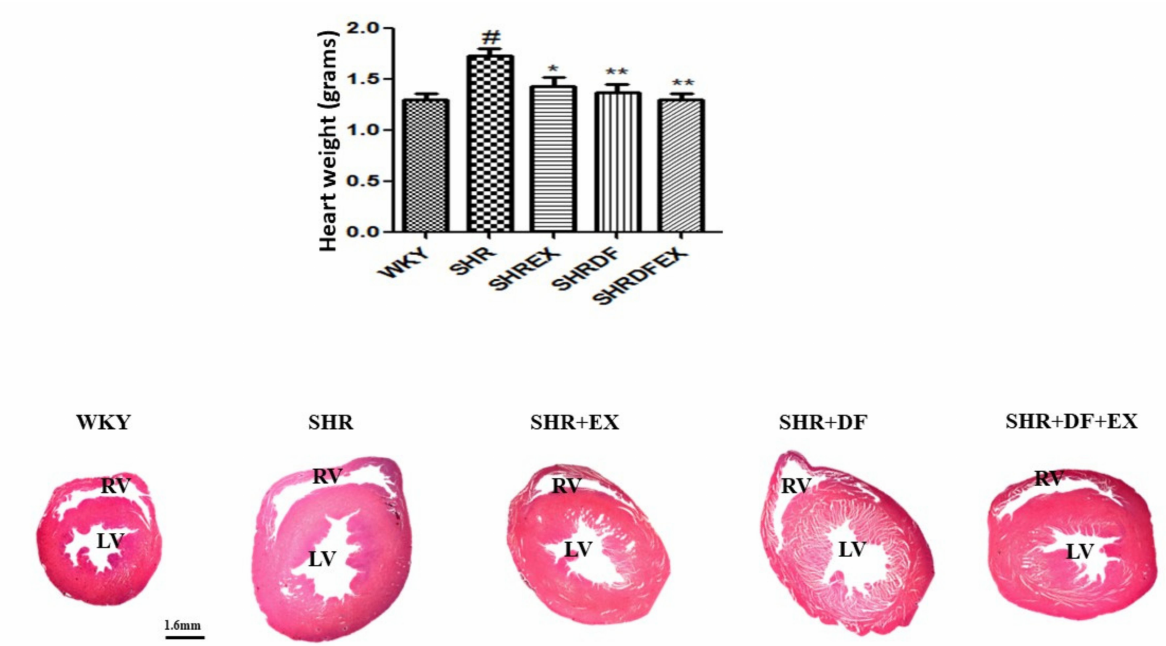
Figure 1. Effect of DF bioactive peptide and combination of exercise on SHR rat heart. ( A ) heart weight ( B ) tomography of cardiac tissue. Each bar represents mean ± SD ( n = 8). # p < 0.01 compared to WKY, * p < 0.05 and ** p < 0.01 compared to